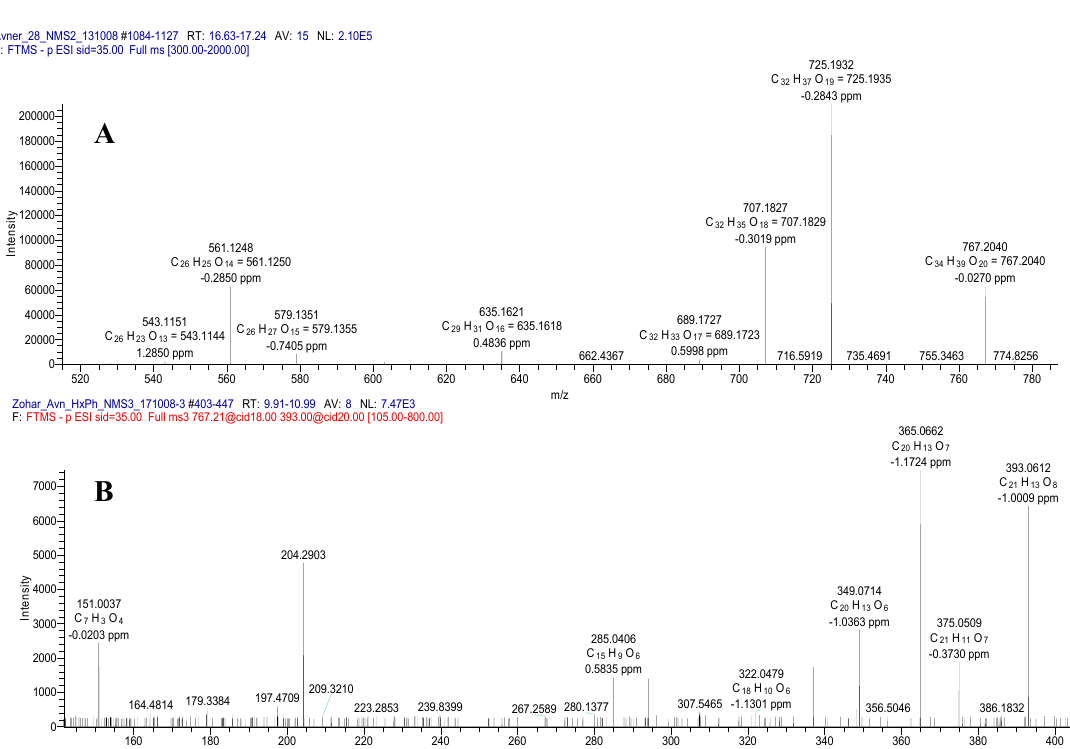
Figure 2. Mass spectra of Compound 1 in the negative mode, full mass spectrum ( A ), and MS 3 ( B ).